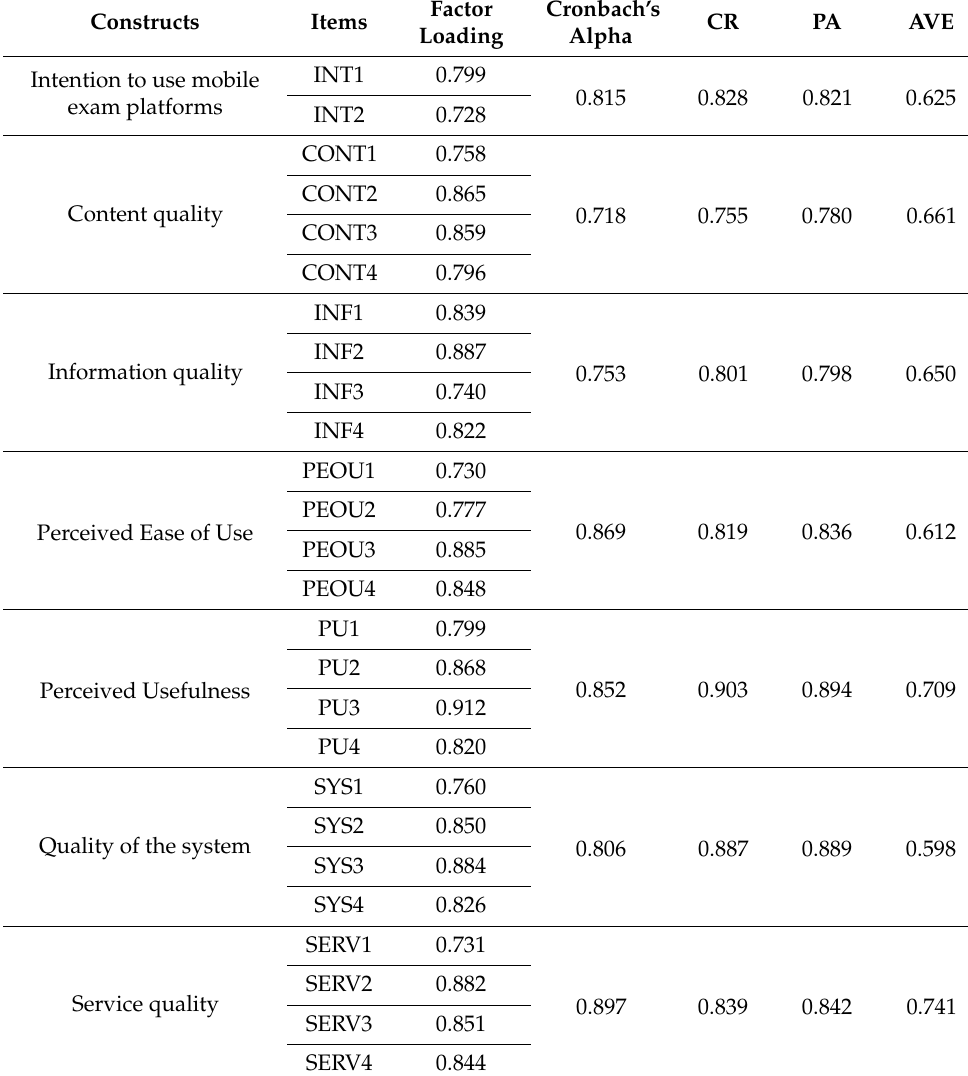
Table 4. Convergent validity results that assure acceptable values (Factor loading, Cronbach’s